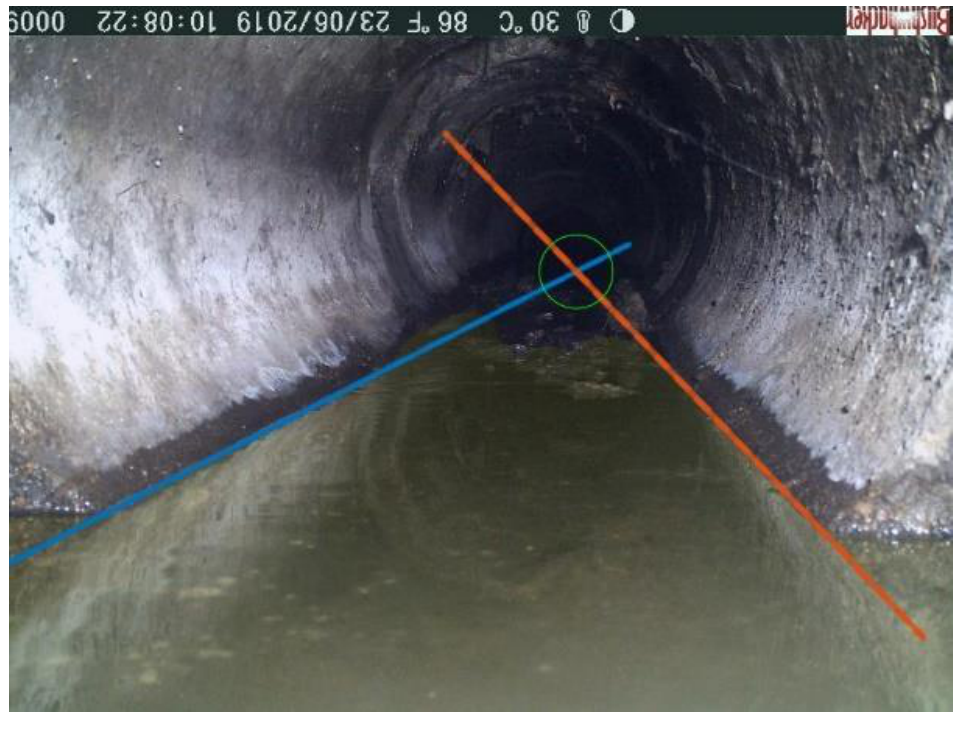
Figure 5. Detection of wastewater boundary line and imaginary circle at intersection.